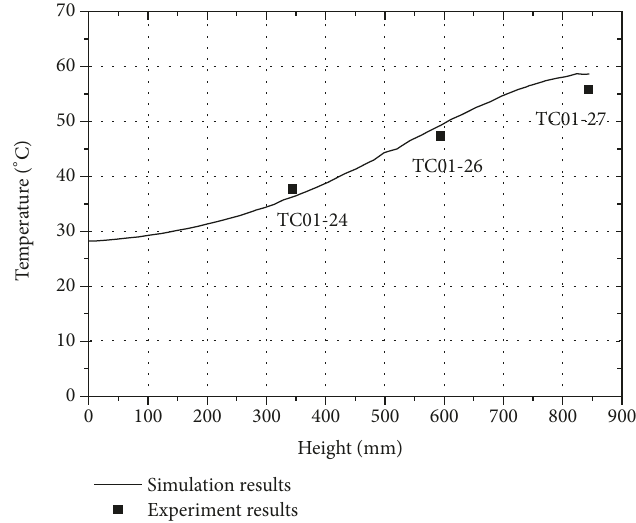
Figure 13: The temperature contrast of simulation and experiment at the support front plate in Test B1.